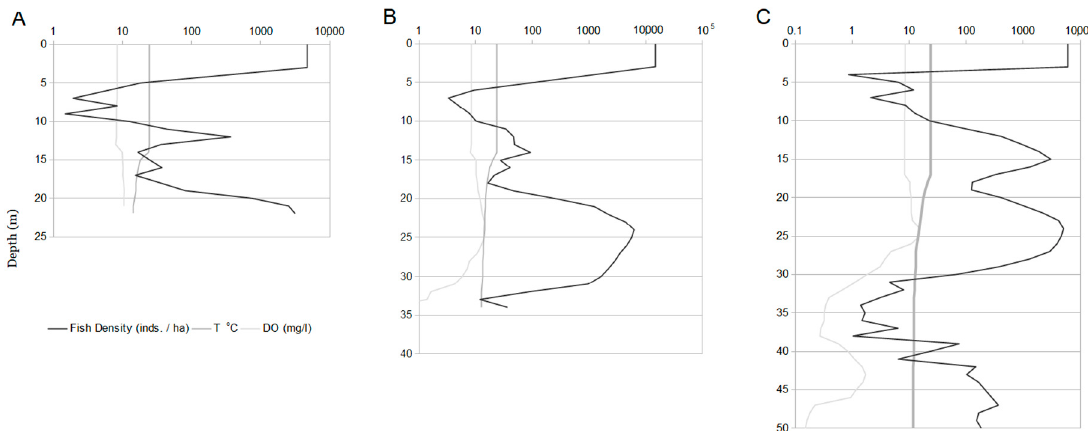
Figure 15. Variations of density (inds. / ha), dissolved oxygen (mg / L) and water temperature ( ◦ C) with depth (m) at the three di ff erent sampling locations of Lake Trichonis (( A ). Sampling point S1 ( B ). Sampling point S2 ( C ). Sampling point